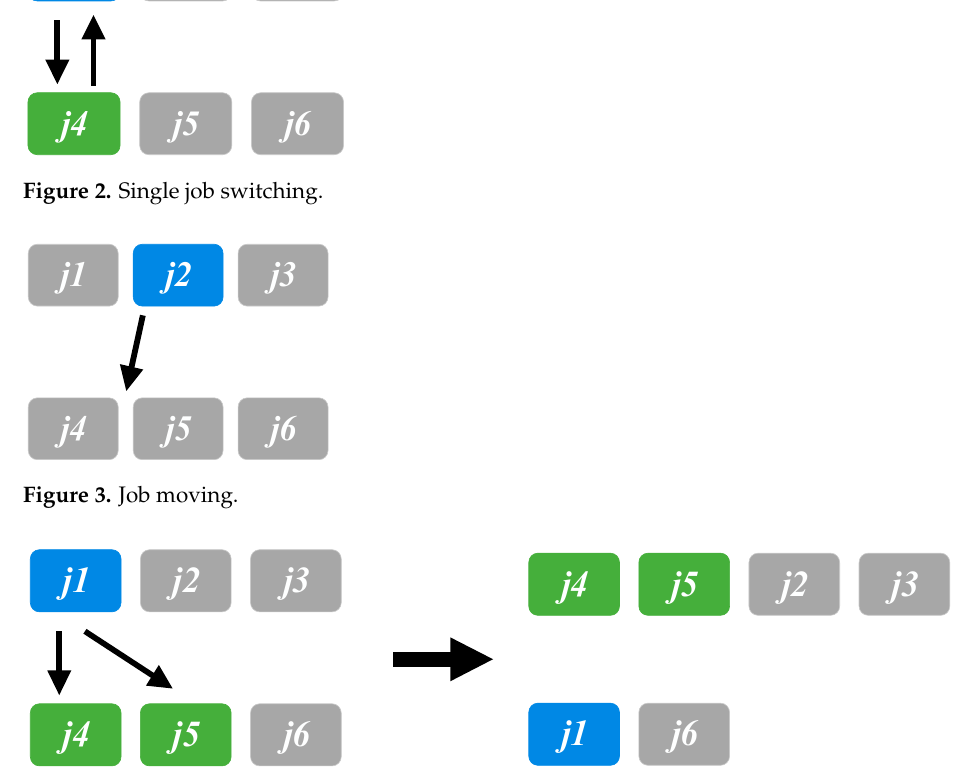
Figure 4. One-to-two job switching.